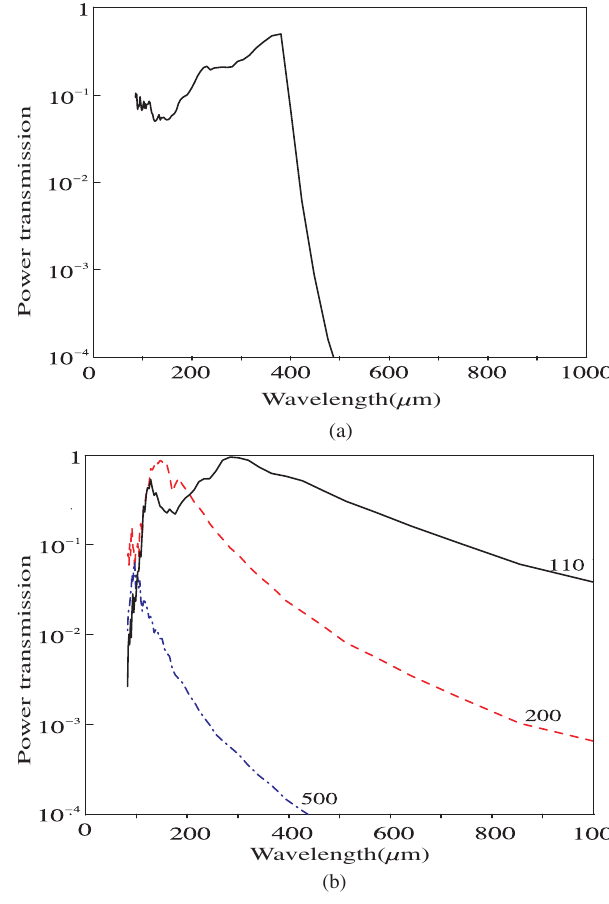
FIG. 4. (Color) Terahertz time domain measurements of the power transmission characteristics of: (a) a waveguide array plate filter, designed for a cutoff wavelength of 398 mm and (b) three wire mesh filters with different number of lines per